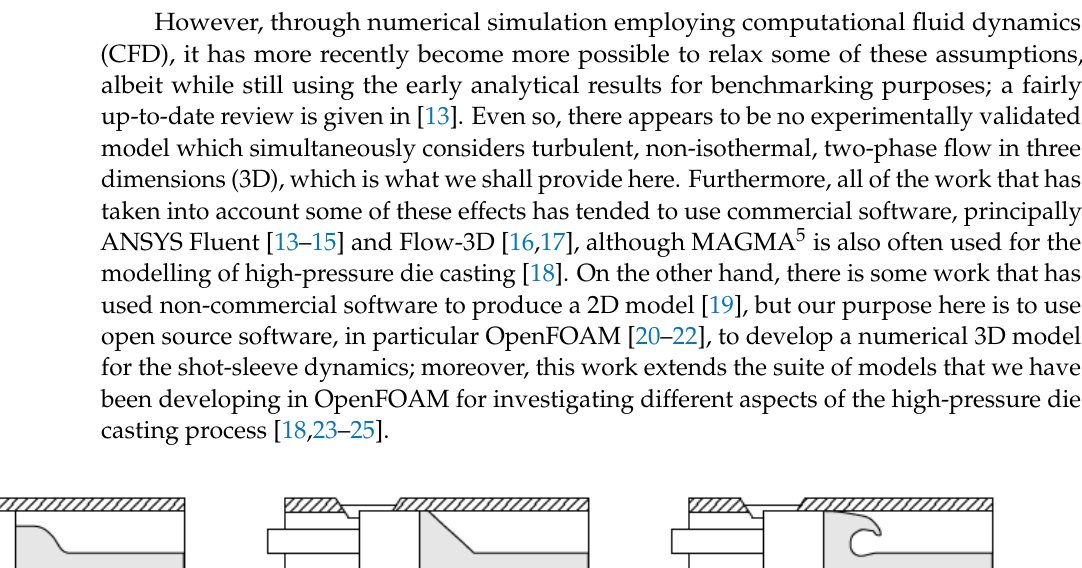
Figure 1. Geometry and schematic representation of the injection system of a die casting machine with a horizontal shot sleeve.